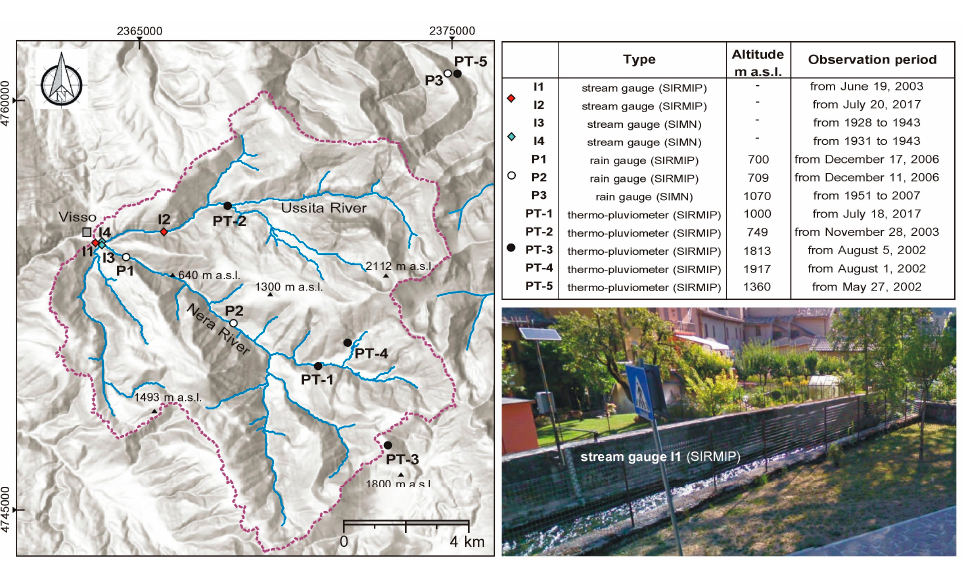
Figure 2. Nera River catchment at Visso section (A = 130 km 2 ) with the location and description of the hydro-meteorological stations.